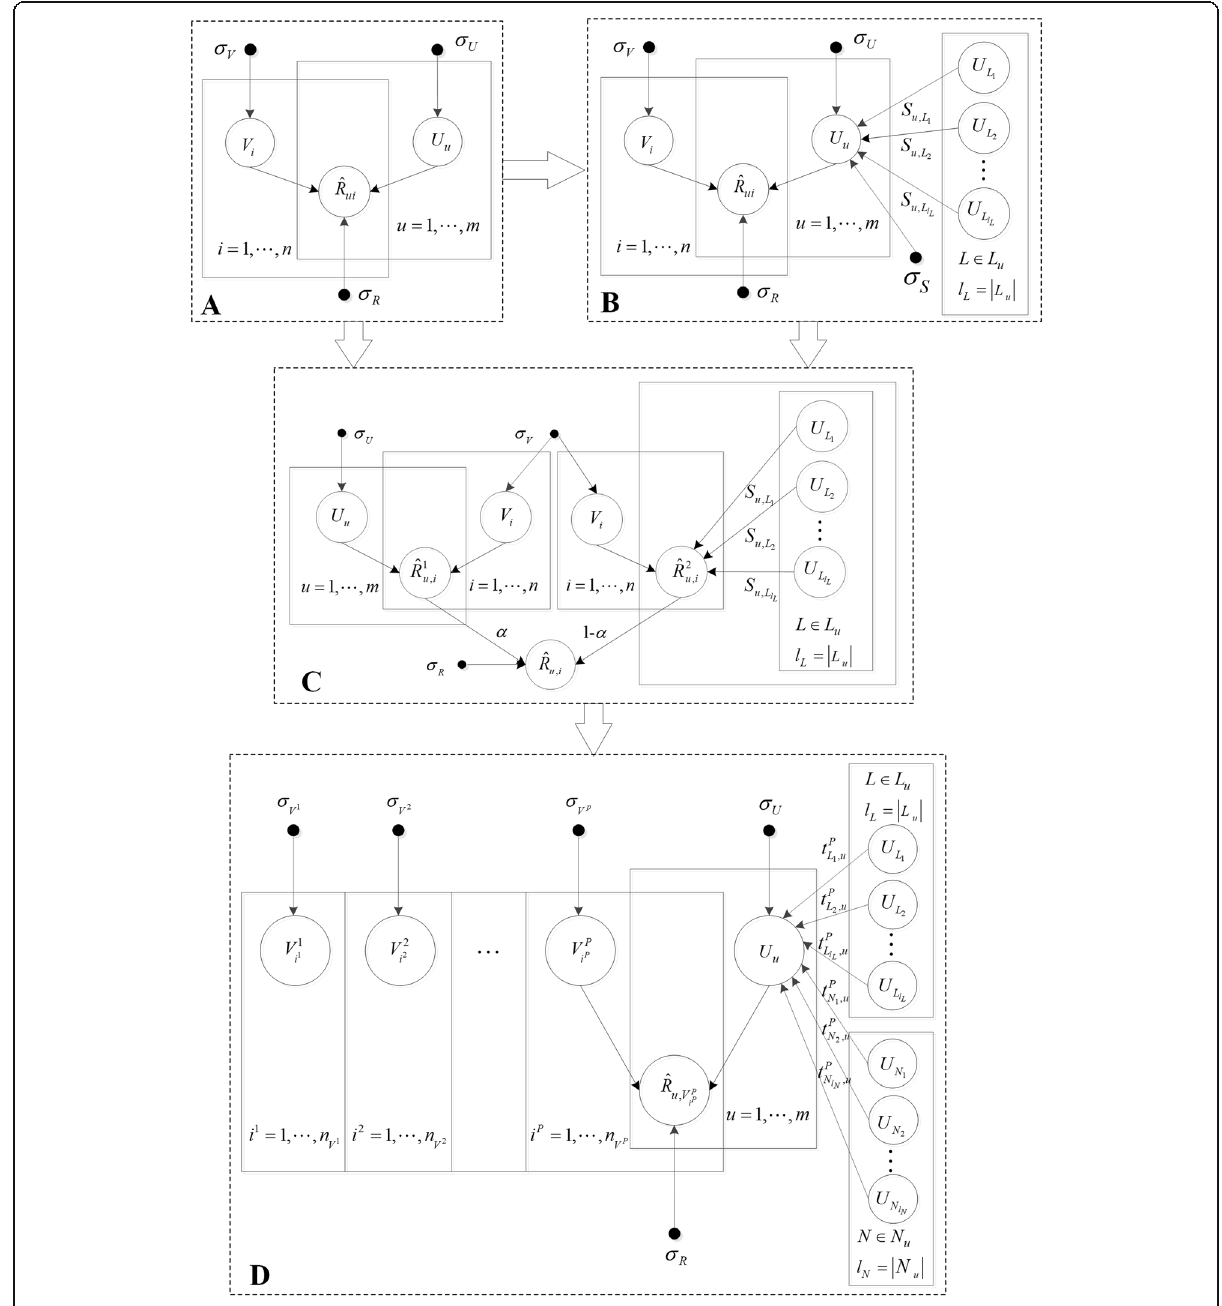
Fig. 2 Schematic diagram of the process of the SPMF recommendation algorithm. a PMF. b SocialMF. c STE. d